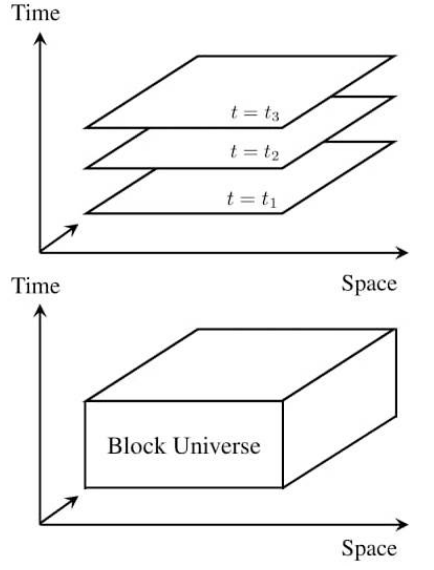
Figure 4. Newtonian